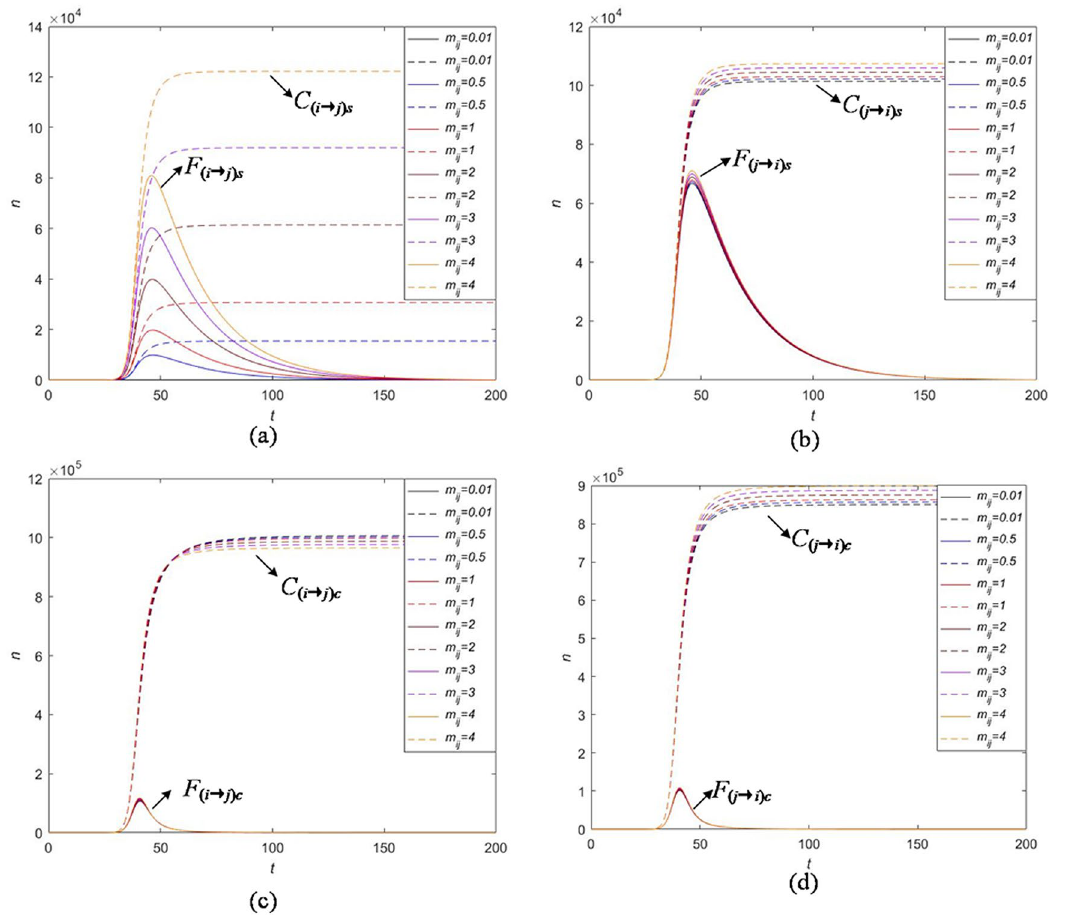
Figure 13. Numerical experiments on the effect of parameter m ij on cross-transmission with strong attraction and continuous attraction: ( a ) strong attraction from information i to information j ; ( b ) strong attraction from information j to information i ; ( c ) continuous attraction from information i to information j ; ( d ) continuous attraction from information j to information i